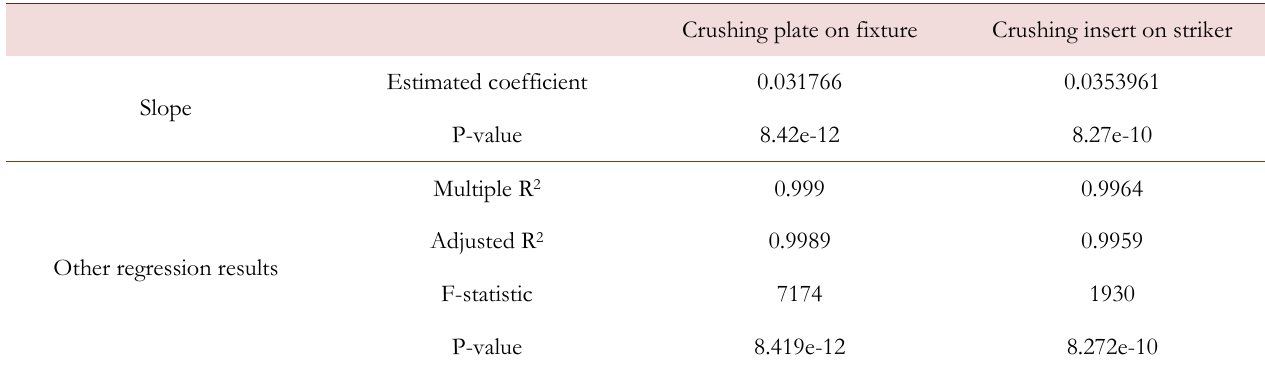
Table 2: Regression results for the two linear models with null intercept plotted in Fig. 8, where the final displacement is expressed as a function of the impact